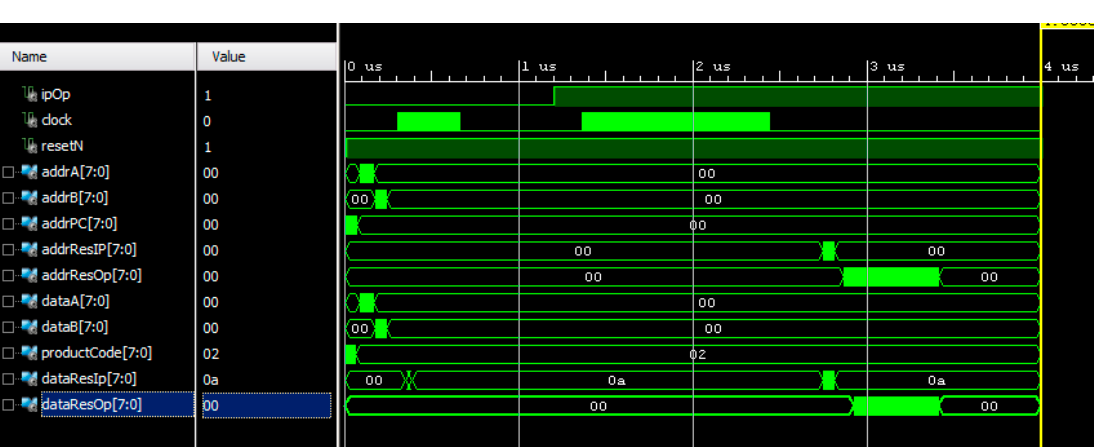
Figure 9. Simulation study results: Computation and results read-out.